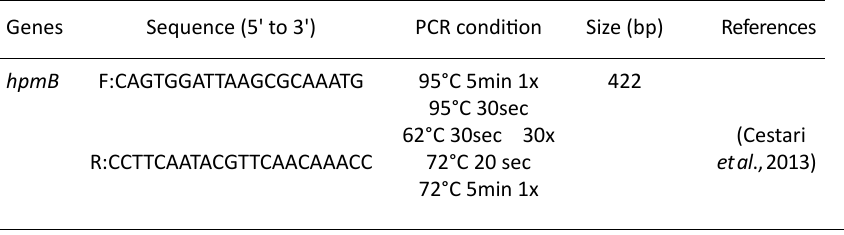
table 1. Primer sequence of hpm B gene and PCR condition Genes Sequence (5' to